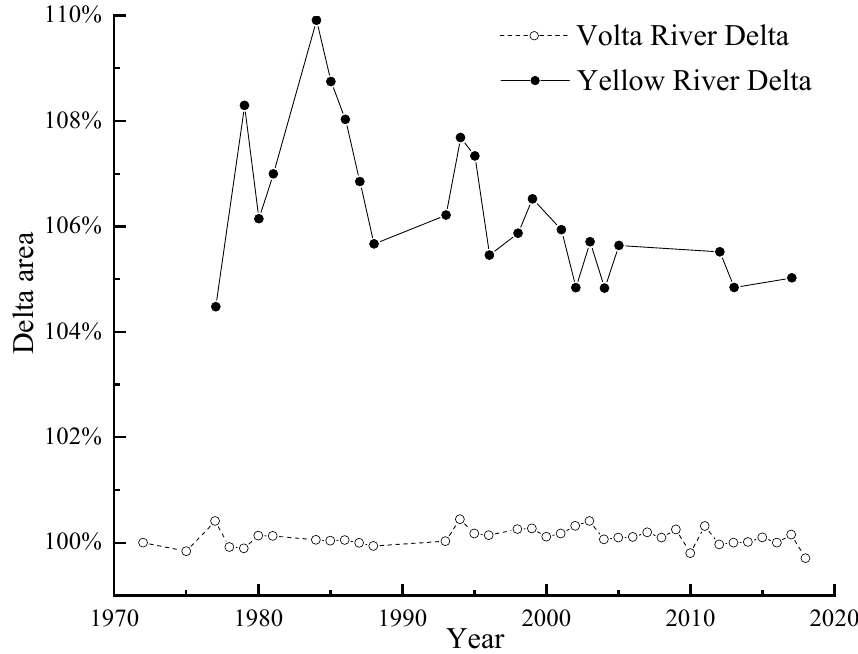
Figure 7. Evolution of the delta areas of the Volta River Delta and the Yellow River Delta. The areas of two deltas were normalized by their corresponding initial areas.